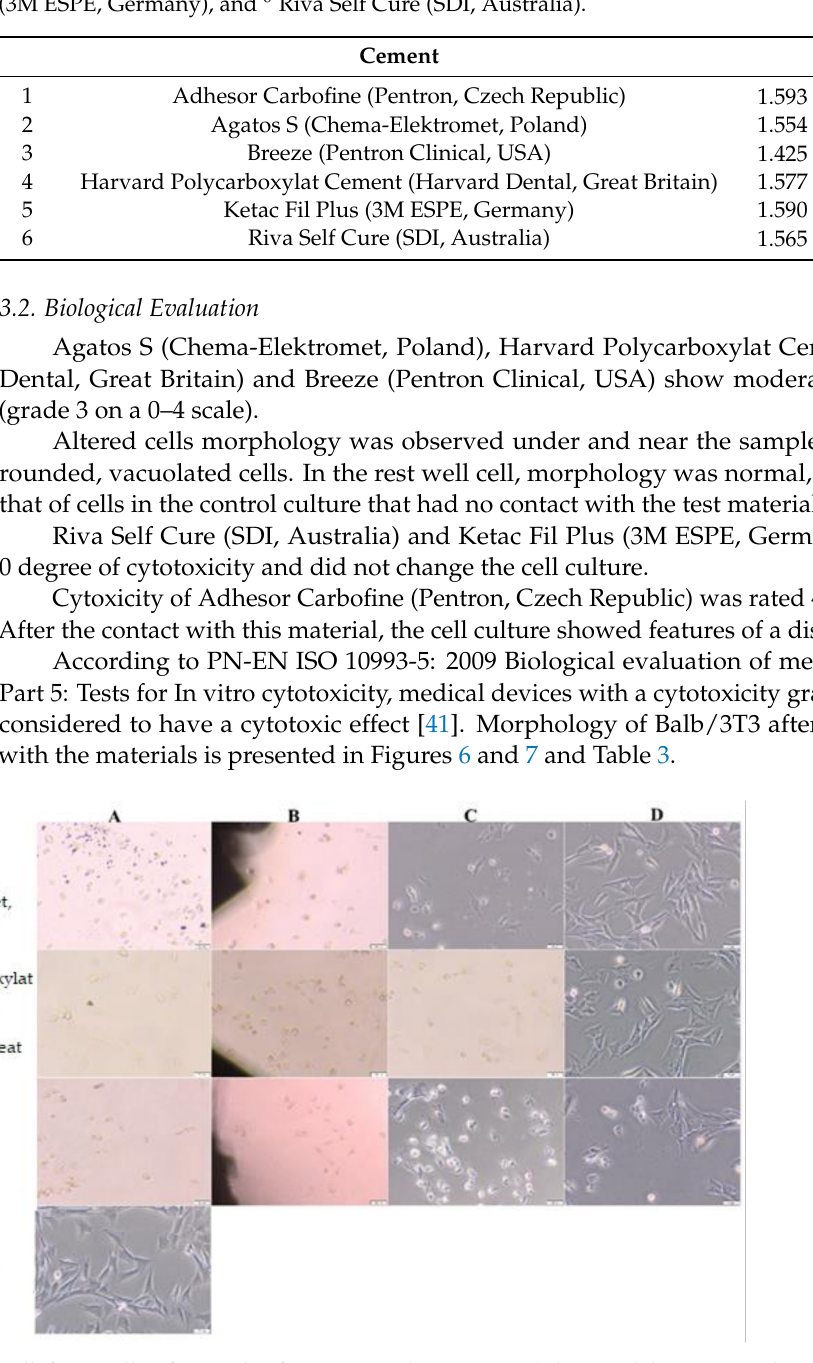
Table 2. Mean value and standard deviation fractal dimension (FD). Superscript indicates significant difference (post hoc ANOVA test, least significant difference, p < 0.05) to tested cement: 1 Adhesor